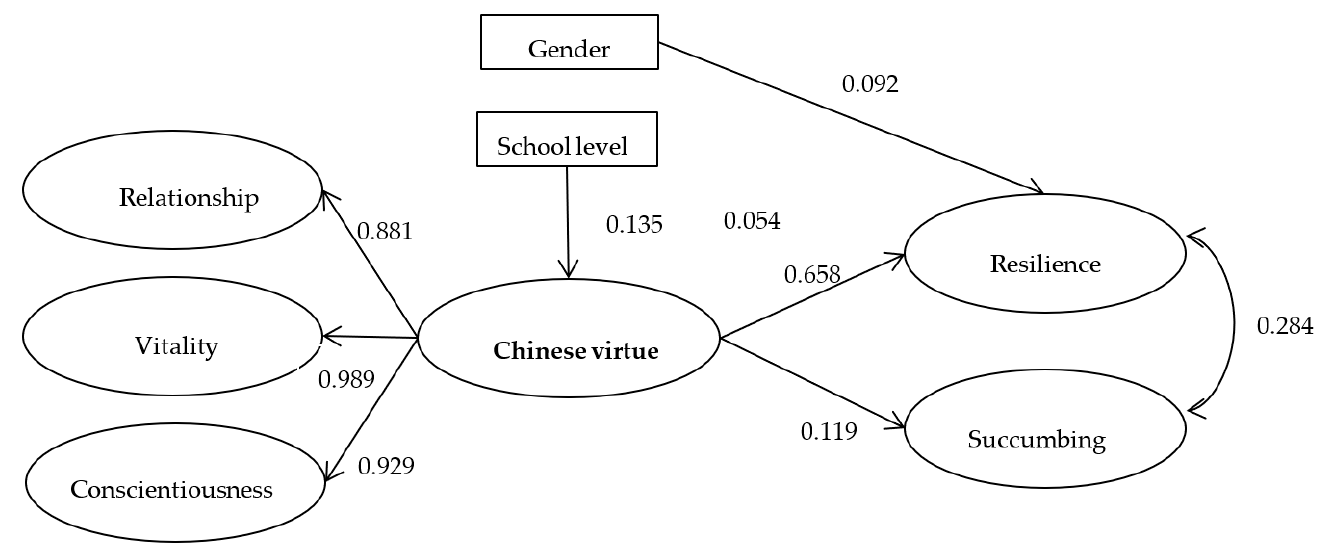
Figure 2. SEM Model of Chinese Virtues and Resilience.